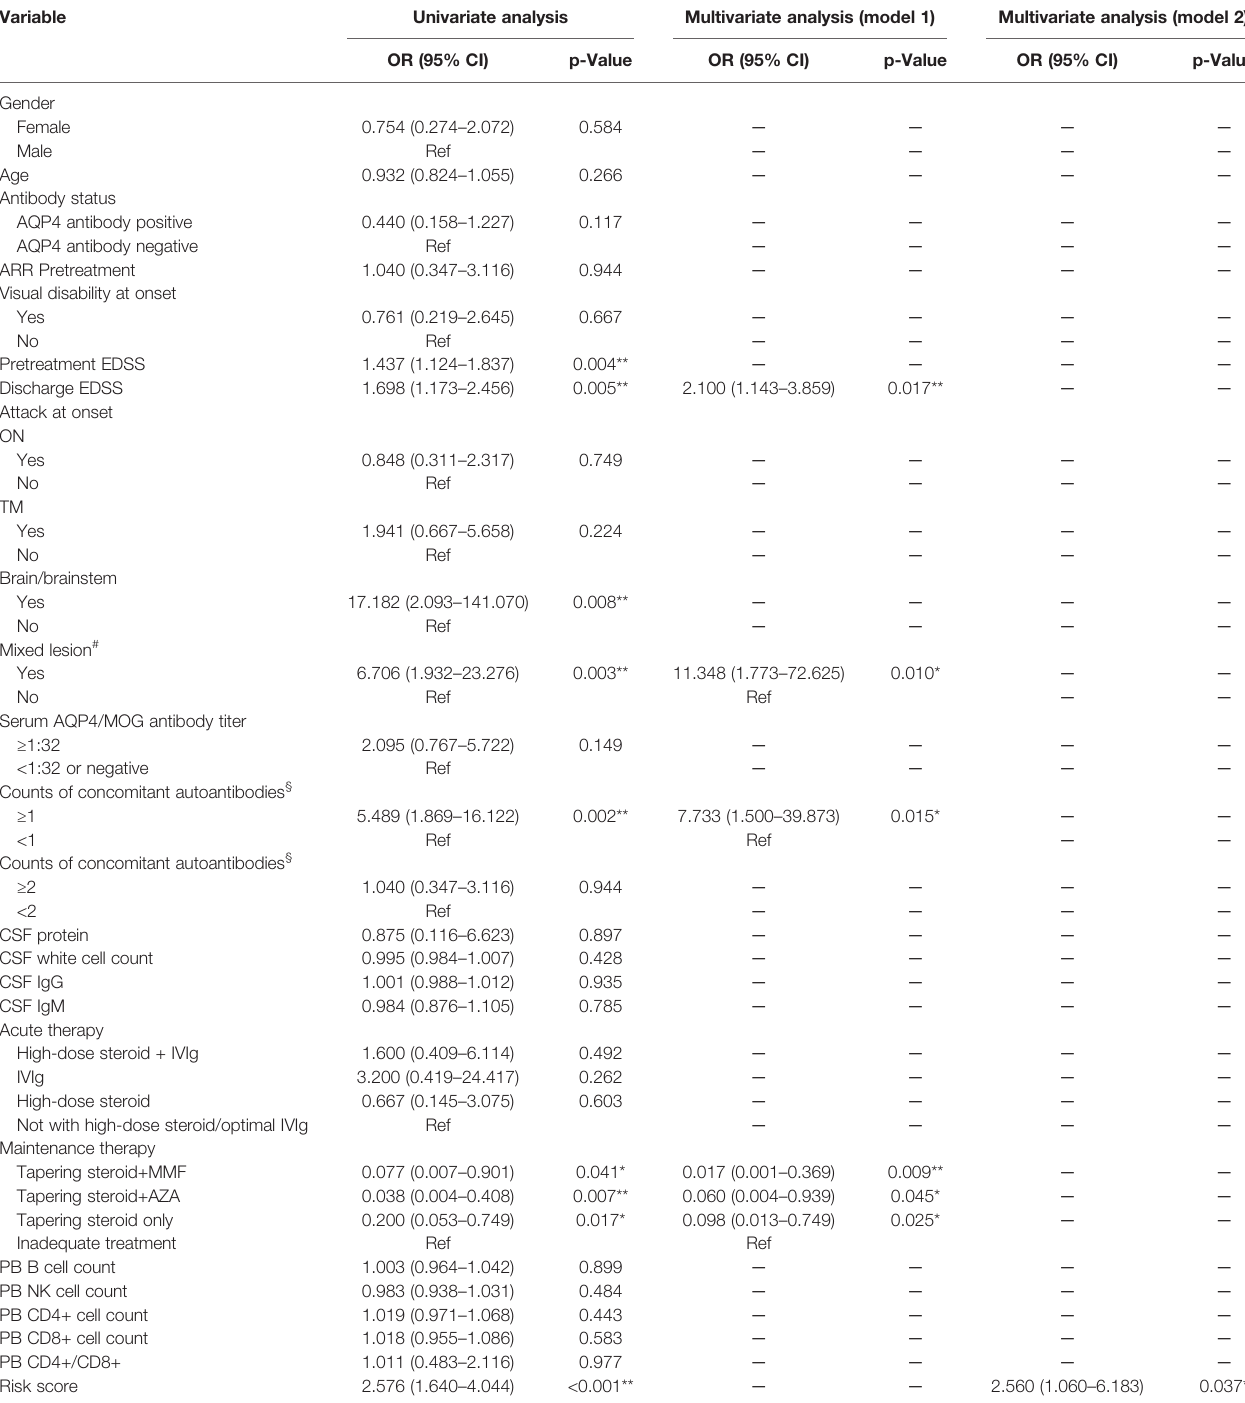
TABLE 5 | Risk factors of relapse using univariate and multivariate logistic regressions in 1-year